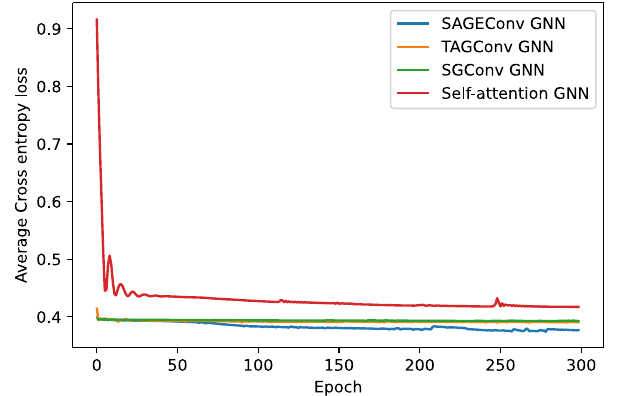
Figure 2. The processes aim at the two-category classification, in which “self-attention GNN” refers to our improved